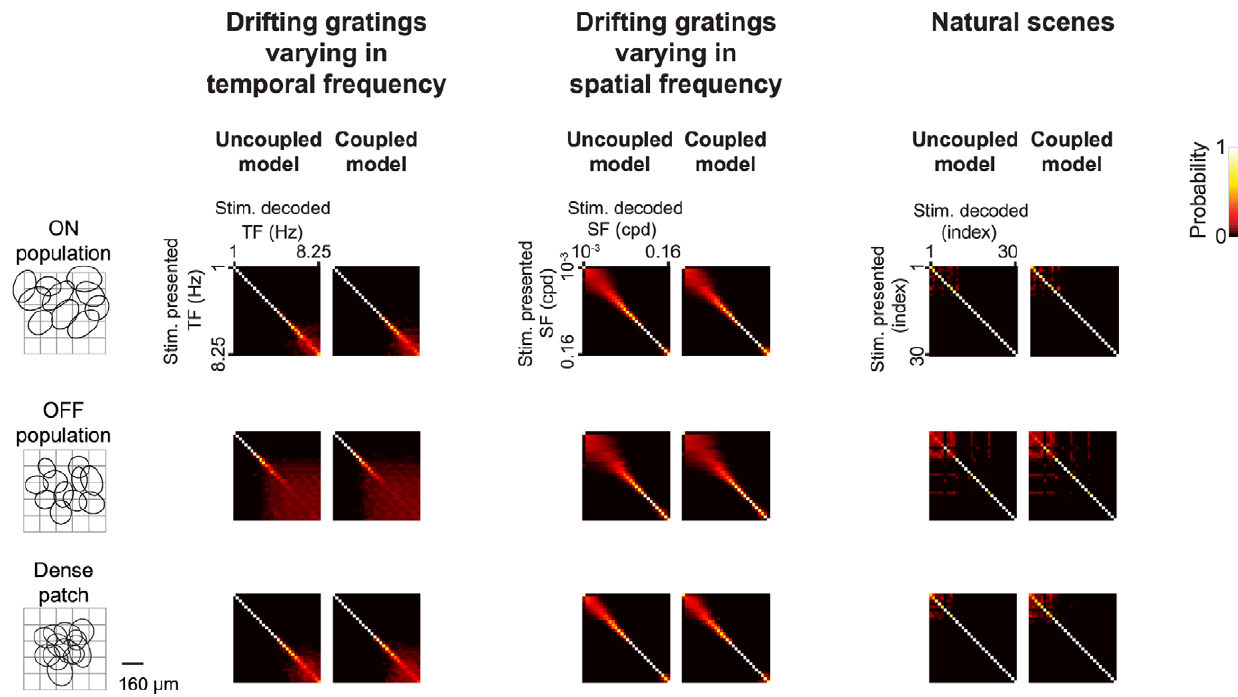
Figure 7. Posterior stimulus distributions generated using models that included correlations among the ganglion cells and models that treated the ganglion cells as independent. The posterior stimulus distributions (matrices) were calculated using three populations of cells: a patch of transient ON cells ( n= 10 cells), a patch of transient OFF cells ( n= 11 cells), and a patch that included all the cells recorded in a local region of the retina ( n= 12 cells). For each population, models were built without correlations ( left ) and with correlations ( right ) included. Distances between coupled and uncoupled posteriors were very low: MSE a values were below 0.05, and K-L a values were below 0.1 bits. To avoid data limitation, response distributions for the population were taken directly from the analytical form of the model, as in